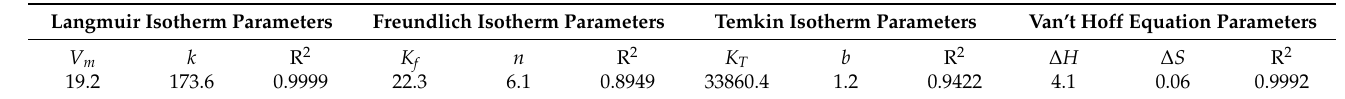
Figure 5. Application of Langmuir ( a ), Freundlich ( b ), Temkin ( c ) and van’t Hoff ( d ) models to the experimental data. Table 1. Isotherms and van’t Hoff equation parameters calculated for As(V) ions adsorption onto resin impregnated with permethylated β